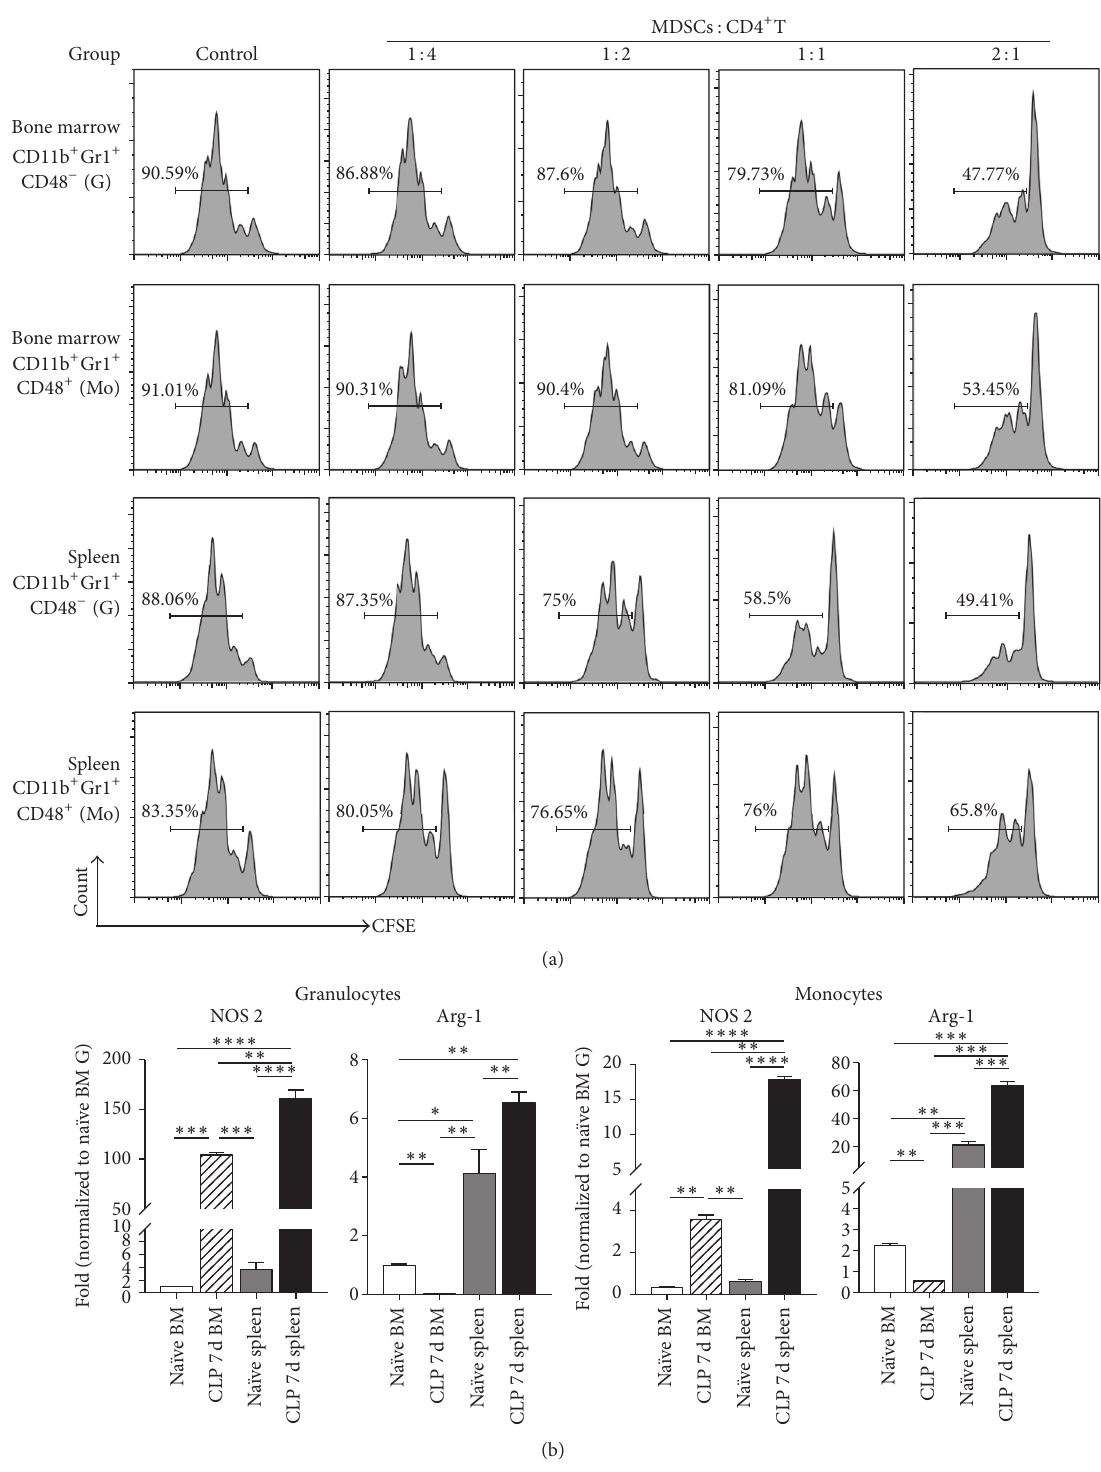
Figure 4: Immune suppression by MDSCs sorted by Gfi1:GFP expression. (a) Sorted MDSC subsets were cocultured with CFSE-labeled splenic CD4 + T cells isolated from na¨ıve spleen by magnetic cell sorting. Anti-CD3 and anti-CD28 antibodies were applied to induce CD4 + T-cellproliferation.After72 h,theproportionofproliferatingCD4 + TcellswasevaluatedbyCFSEstainingandflowcytometry.Representative graphs show data from three independent replications. (b) Sorted CD11b + Gr-1 + CD48 − G-MDSCs and CD11b + Gr-1 + CD48 + M-MDSCs were analyzed by real-time qPCR. Probes detecting NOS2 and Arg-1 were used to quantify mRNA levels. Relative expression was normalized to bone marrow derived granulocytes from na¨ıve mice. Data are mean ± SEM of 6–10 mice per group. The experiment was repeated three times, and the values presented are from one representative experiment. ∗ 𝑃 < 0.05 , ∗∗ 𝑃 < 0.01 , ∗∗∗ 𝑃 < 0.001 , ∗∗∗∗ 𝑃 < 0.0001